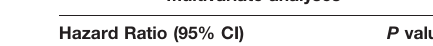
TABLE 5 | Univariate and multivariate analyses of factors associated with and cancer-speci fi c survival (CSS).